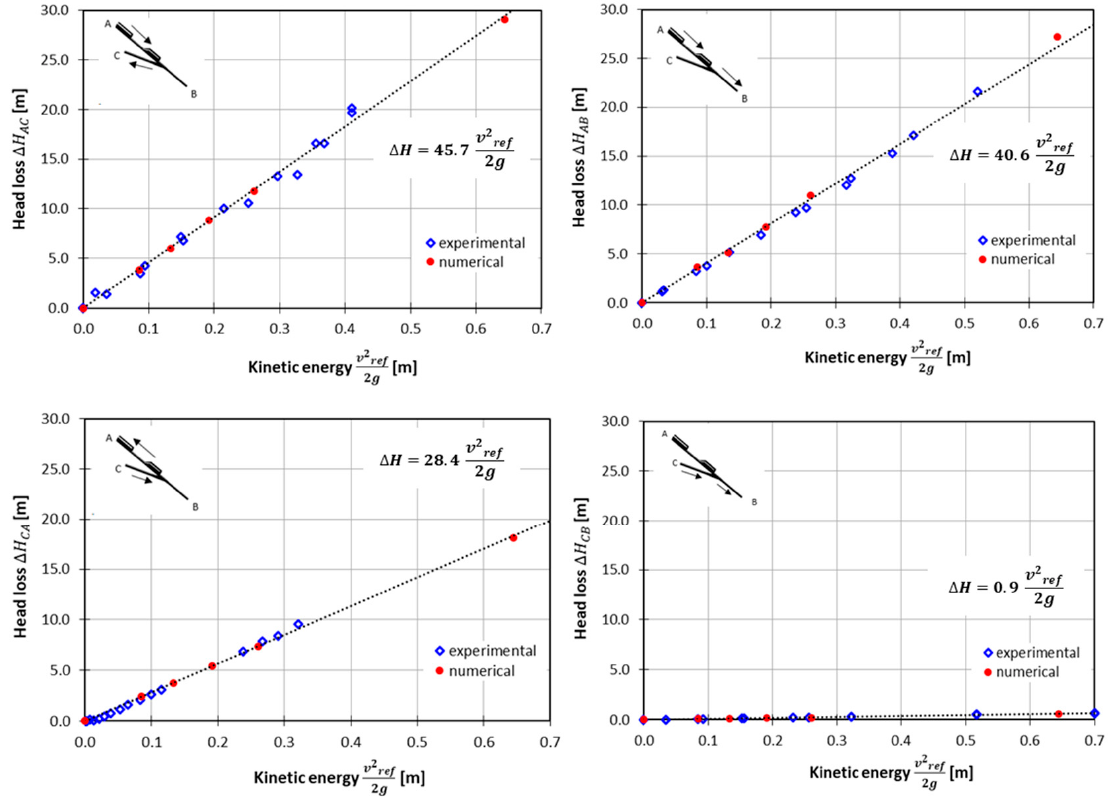
Figure 7. Head loss coe ffi cient for the four flow directions (the best linear fit of combined numerical and experimental data series is shown).